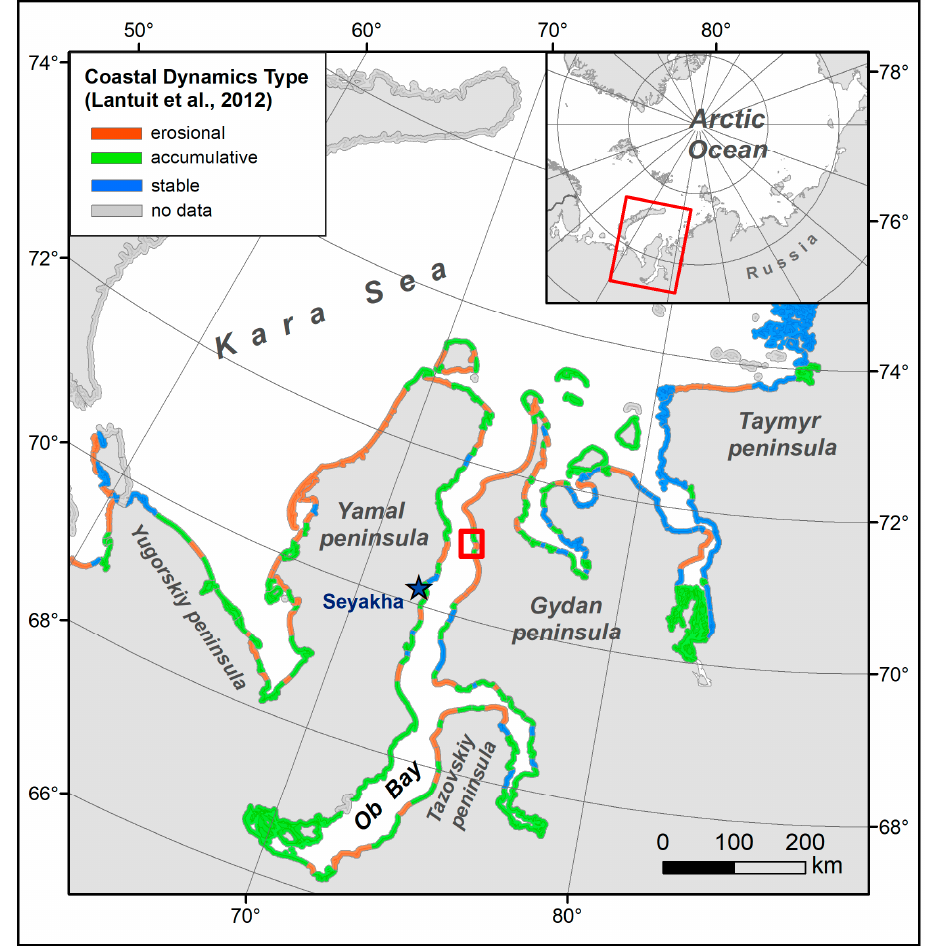
Figure 1. Study area. Red square shows the location of the study area; blue star shows the location of Seyakha weather station; Coastal Dynamics Types – from